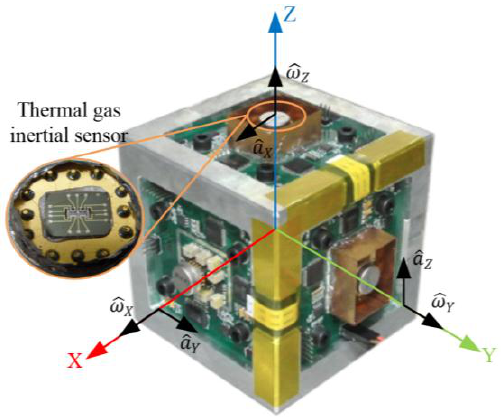
Figure 12. An MIMU using three gas inertial sensors based on thermal expansion [98].